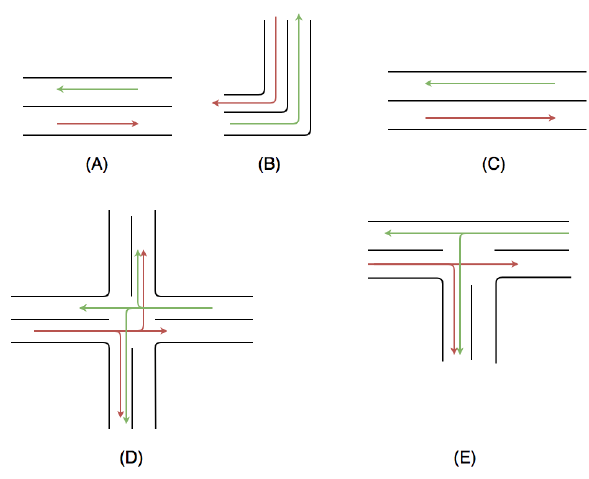
Figure 2. Urban Street Network roads and intersections (source: